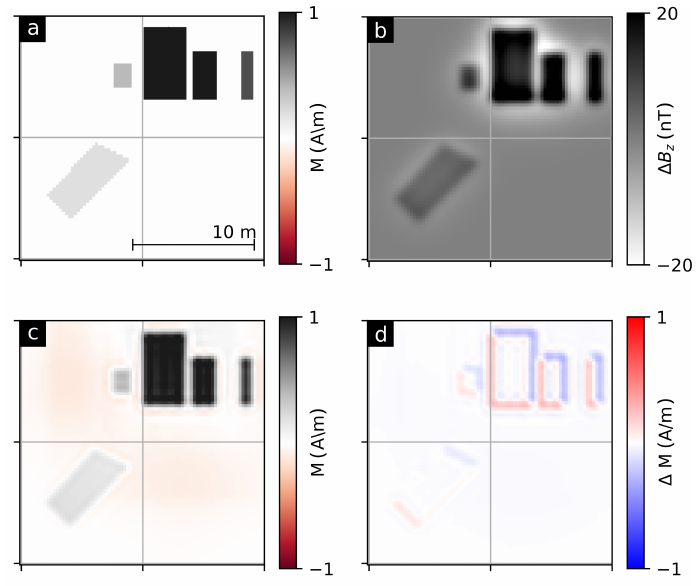
Figure 5. Synthetic case study: ( a ) magnetization distribution at depth range 0.35 m to 0.6 m. ( b ) Resulting gradiometry data of ( a ). ( c ) Magnetization distribution derived from ( b ) via inverse filtering. ( d ) Deviation between ( a ) and ( c ).